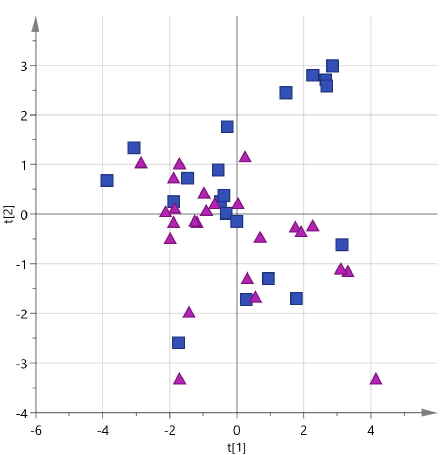
Figure 4. PCA score plot (PC1 vs. PC2) for EVOO samples from Salento categorized by cultivar (blue squares = Cellina; purple triangles = Ogliarola).